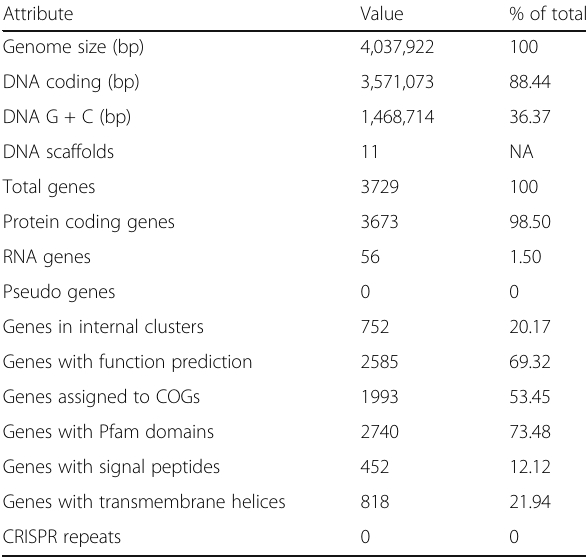
Table 4 Genome statistics of E. meningoseptica